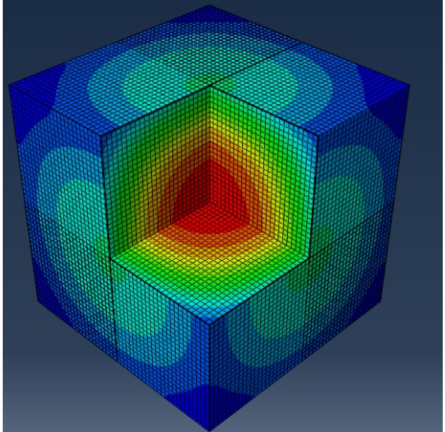
Figure 13. Finite element model at 16.50 h: Temperature (Red = high temperature, Blue = low temperature).